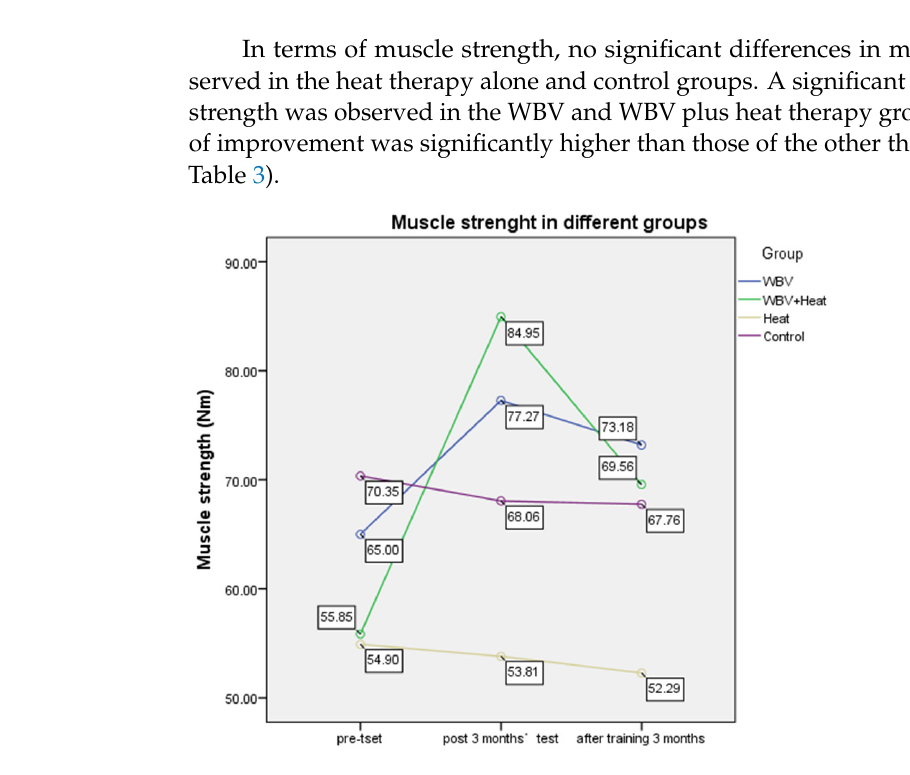
Figure 5. Muscle strength in six months with different groups. Table 3. Comparison of the Training Effect on Muscle Strength in Six Months.